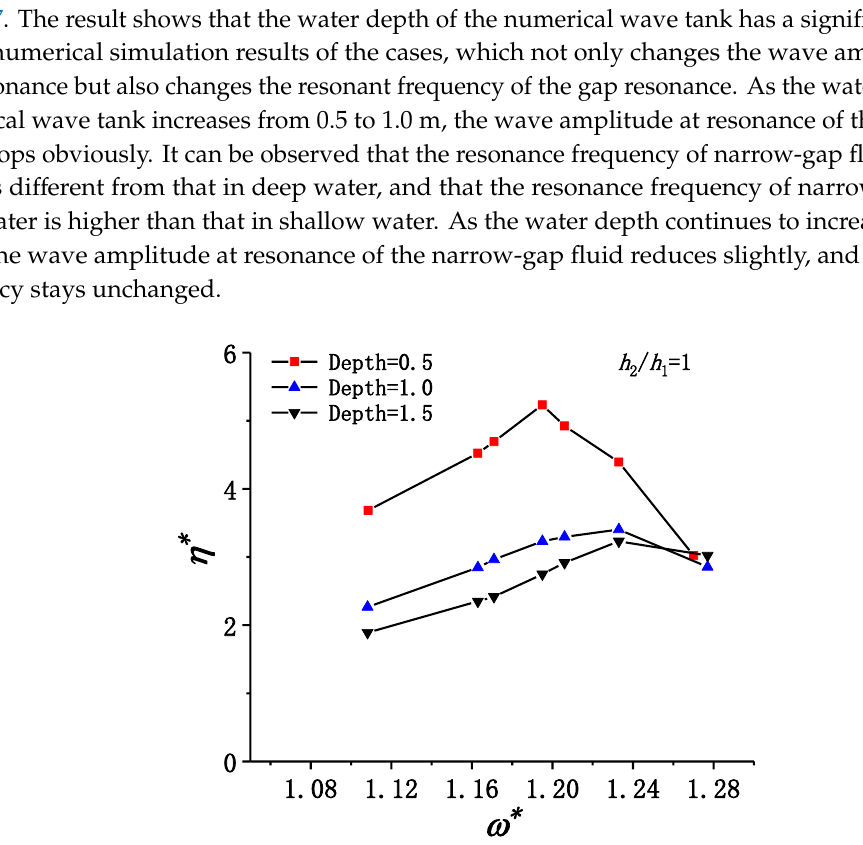
Figure 7. Comparison of fluid oscillation amplitudes for water depths of 0.5, 1 and 1.5 m.